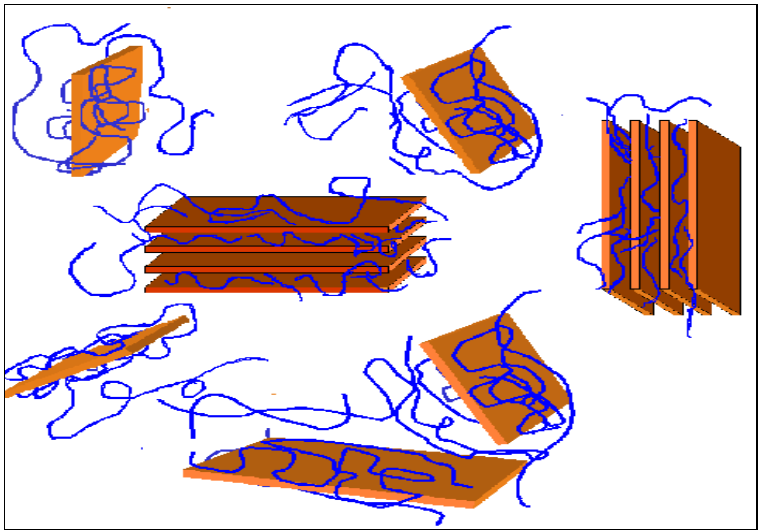
Figure 16. Representation of the structural model for PACN showing intercalated and partially exfoliated clays.